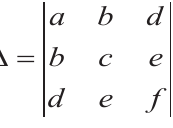
Figure 2. Relationship between the threshold of SDS Z